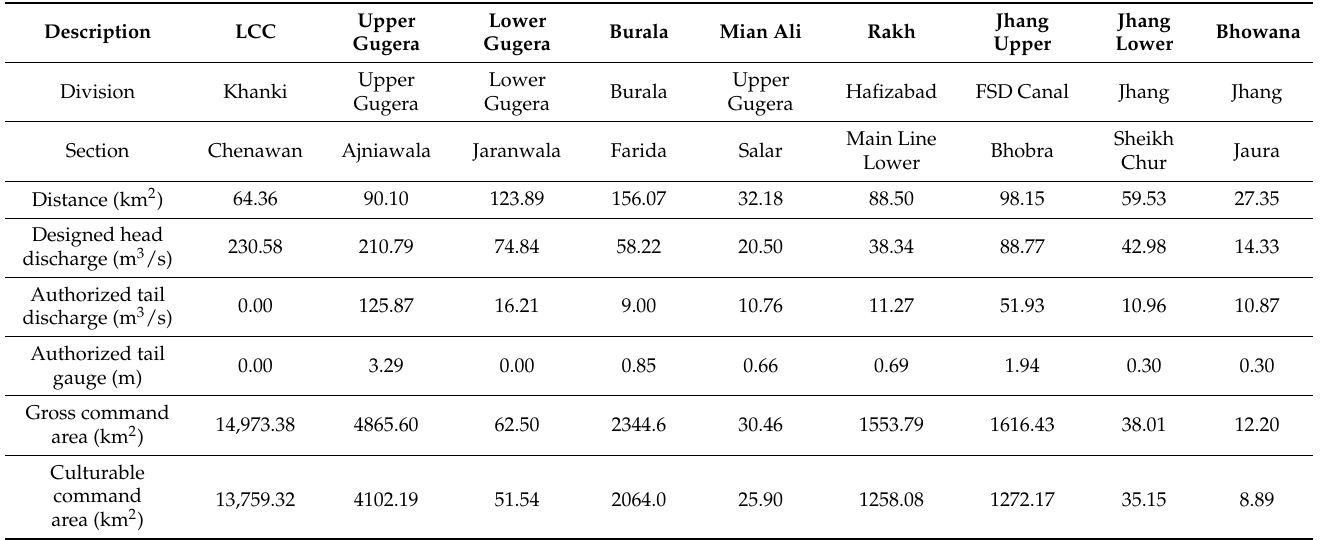
Table 1. Features of main canal, branch canals in Lower Chenab Canal [36].